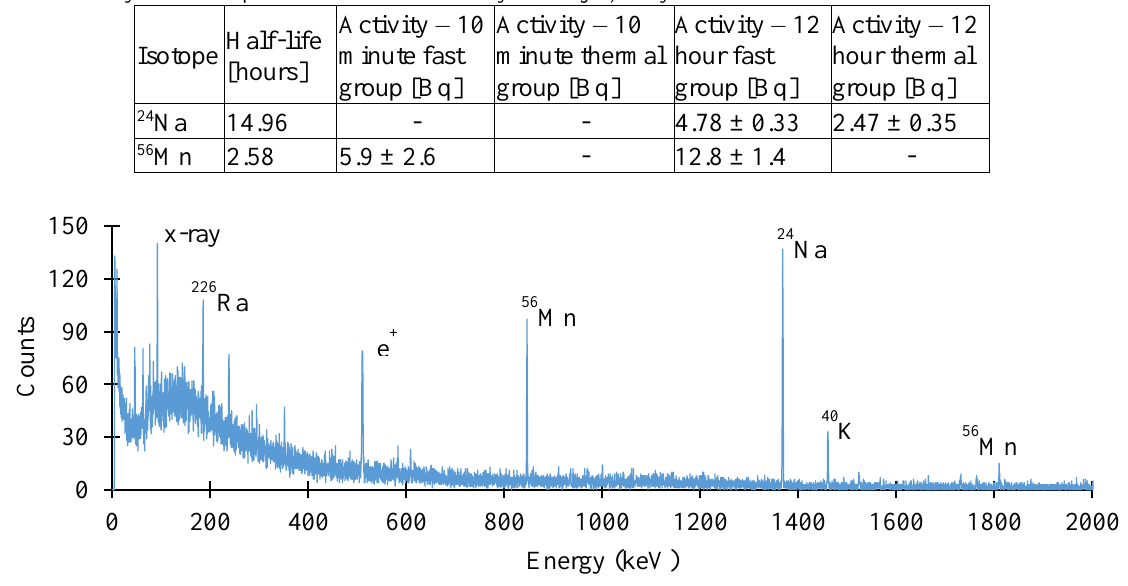
Table 2: Activity of the isotopes detected at the University of Sharjah, decay-corrected to the end of activation.